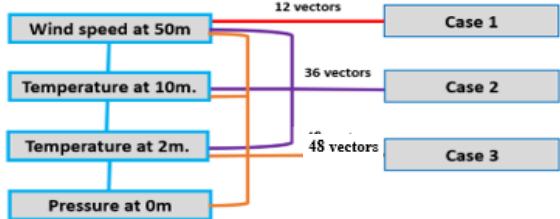
Figure 4. Architecture of the ANN showing the training input and the targets.